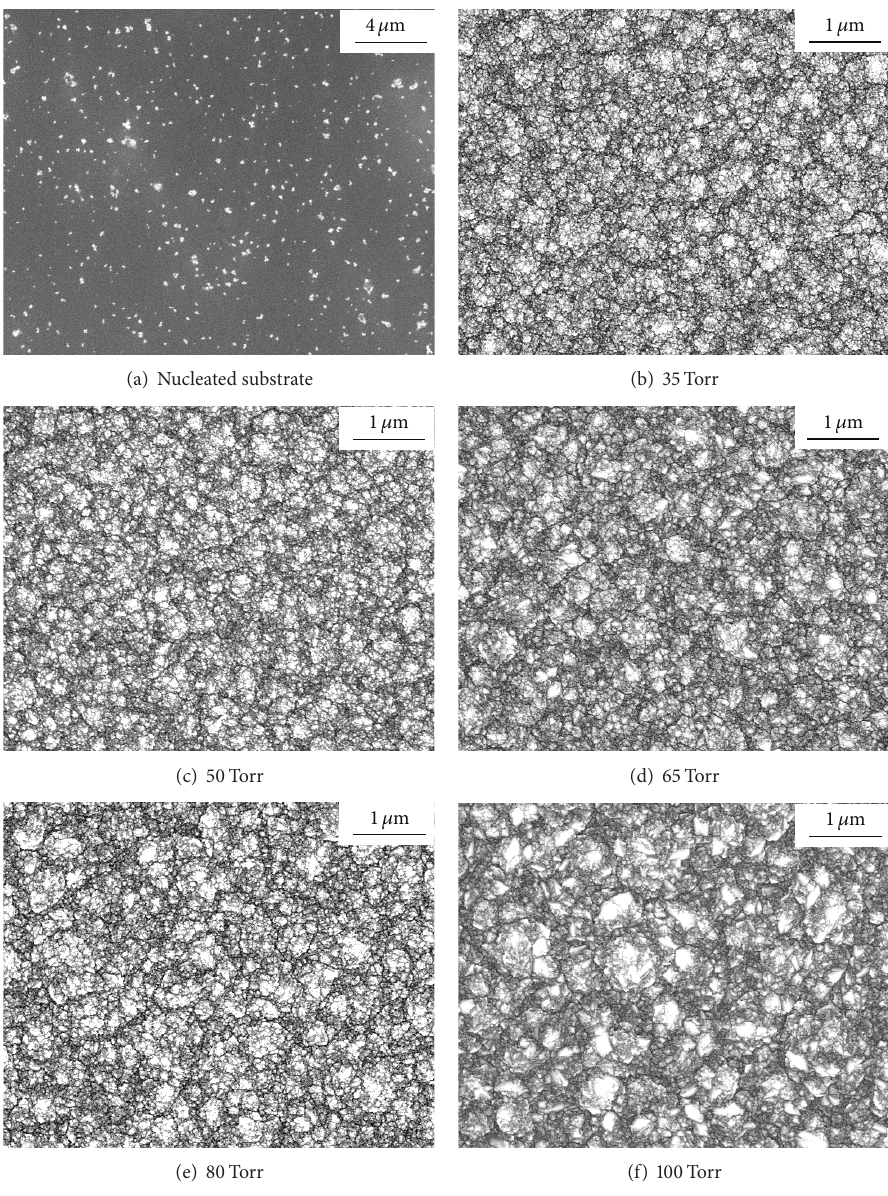
Figure 2: SEM images of (a) quartz substrate spin coated with NDPs and diamond films grown at various working pressures: (b) 35 Torr, (c) 50 Torr, (d) 65 Torr, (e) 80 Torr, and (g) 100 Torr,